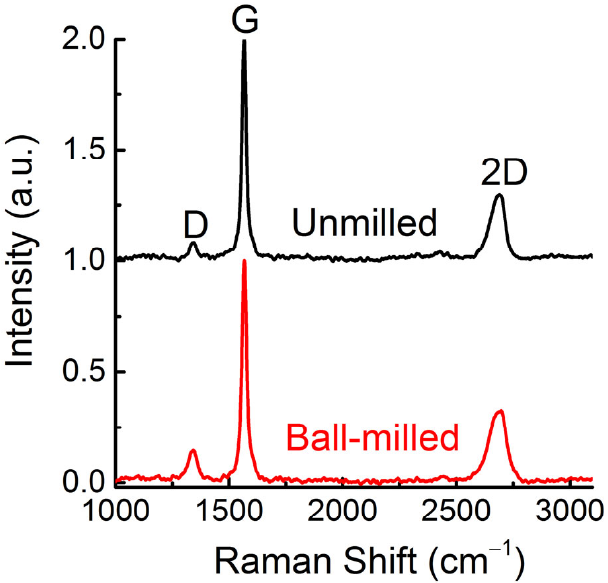
Figure 3. Comparison of the Raman spectra at 532 nm of unmilled and milled sample (after wash ‐ ing).